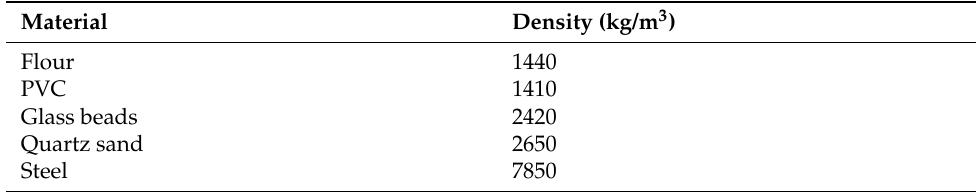
Table 3. Density of materials used in simulations.